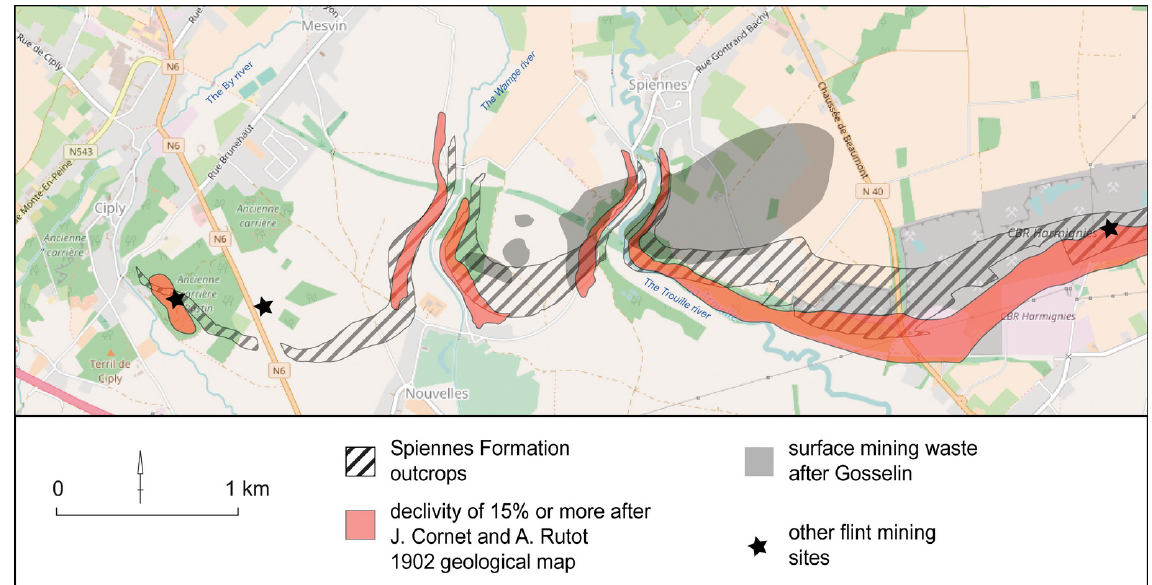
Figure 3. The Neolithic flint mines of Spiennes on the southern edge of the Mons basin. Graphics by M. Woodbury, SPW. Map: OpenStreetMap